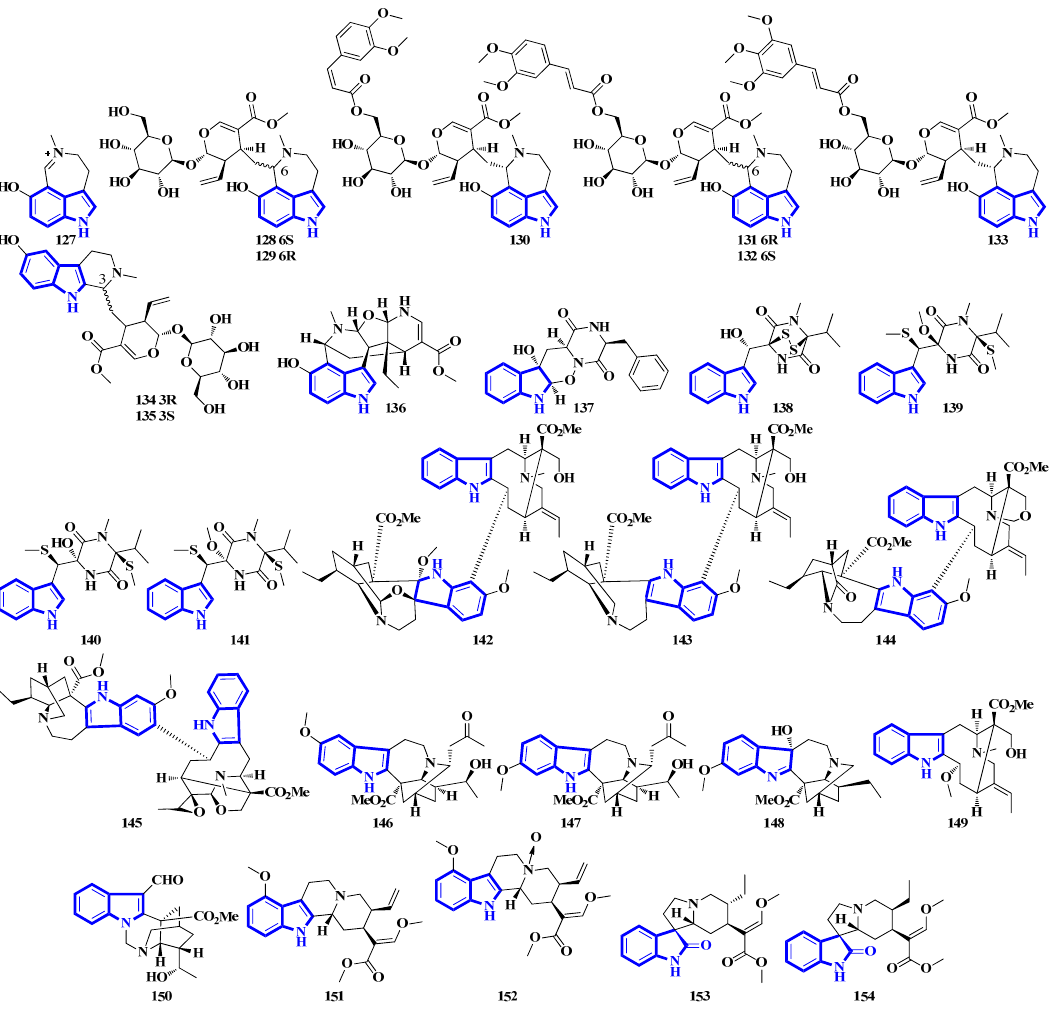
Figure 8. Novel indole alkaloids 127 to 154 .